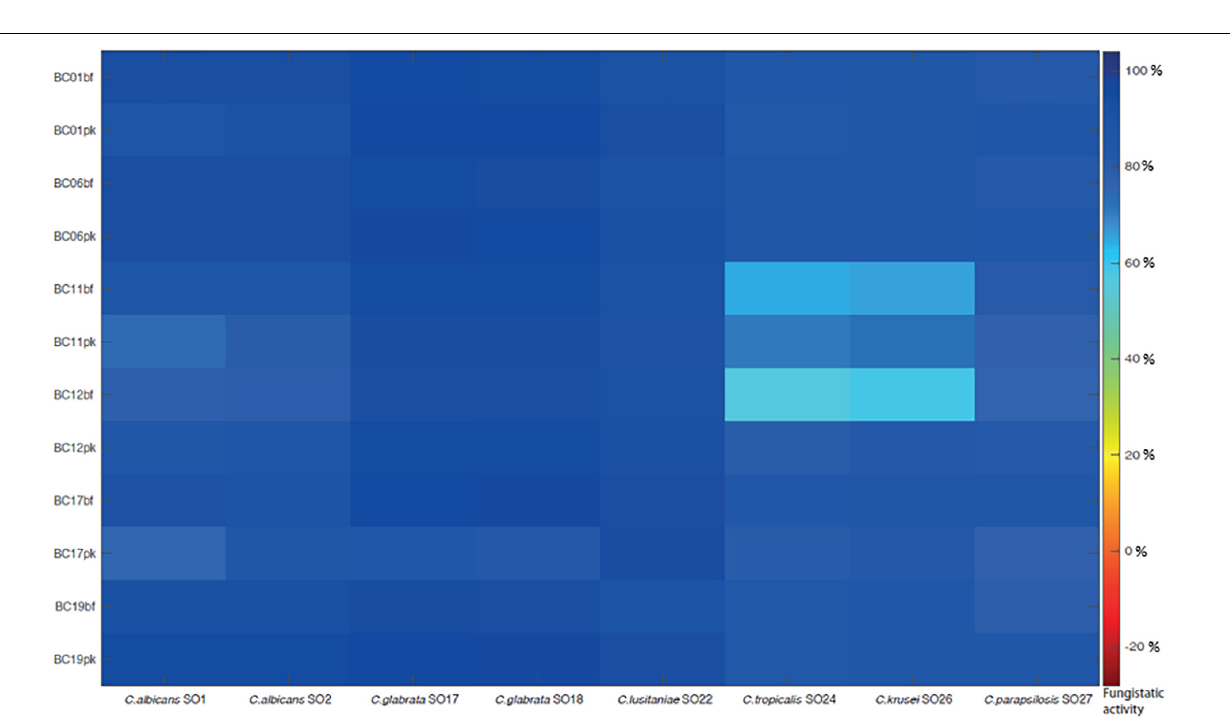
FIGURE 3 | Fungistatic activity of L. crispatus BC1, L. crispatus BC6, L. gasseri BC11, L. gasseri BC12, L. vaginalis BC17, and L. plantarum BC19 bf-CFS and pk-CFS toward clinical Candida isolates, tested in simulated vaginal fluid, pH 4.2. OD 530 nm values were normalized for positive controls and data were expressed as inhibition (%) of Candida growth. Fungistatic activity color scale was